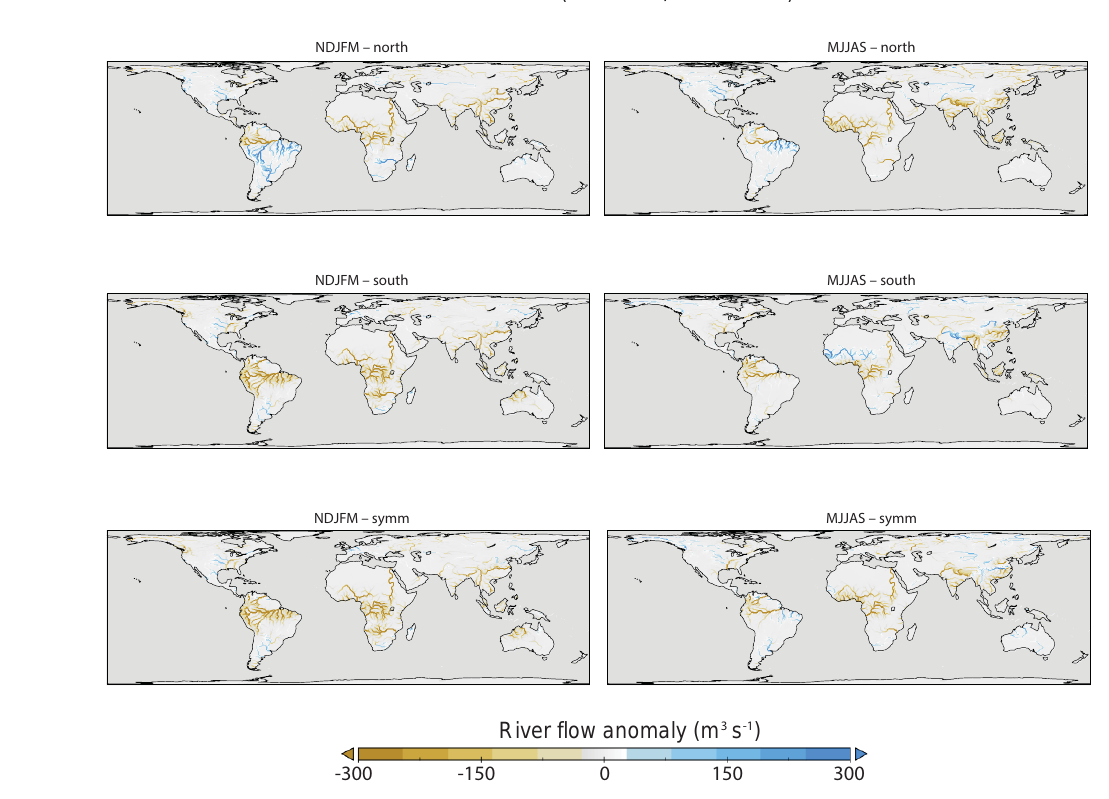
Figure 6. As in Figs. 2 and 4, except for river discharge (m 3 s − 1 , or 10 − 6